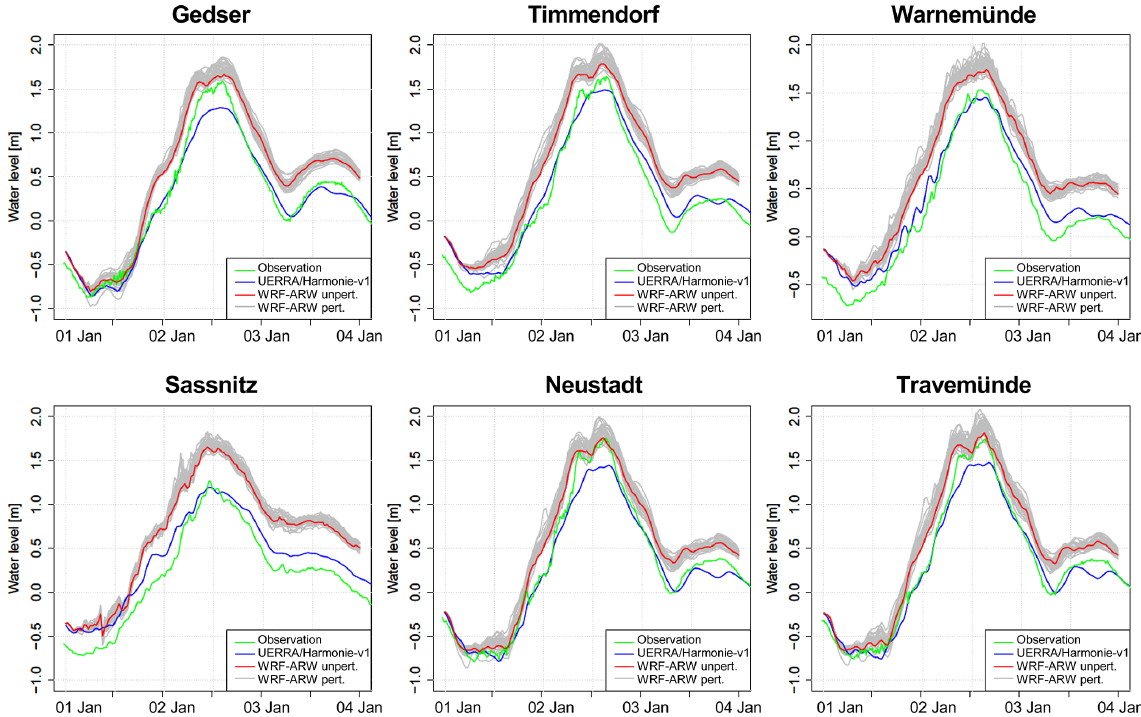
Figure 4. Water level at six stations with the 1 nautical mile GETM model; atmospheric data from UERRA/HARMONIE-v1, WRF-ARW is unperturbed, and the 30 WRF-ARW members are generated with stochastic perturbations.